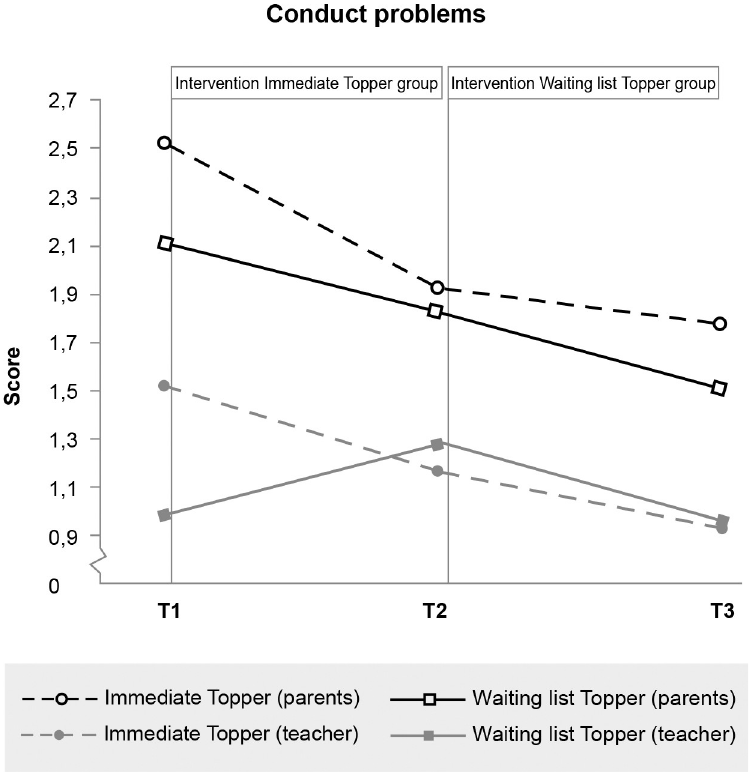
Fig 4. Significant effect of Topper Training on teacher-reported (but not parent-reported) conduct problems.